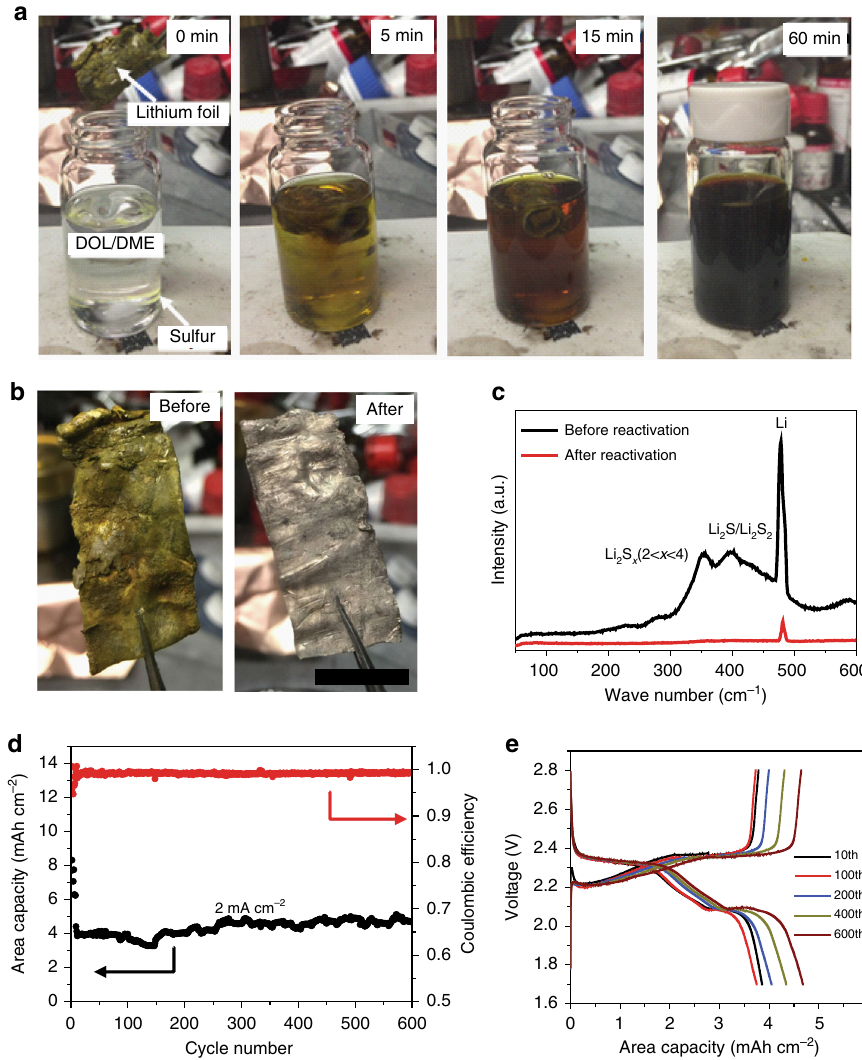
Fig. 2 Dead sul fi de species reaction with sulfur powder. a Optical images of dead sul fi de species on the surface of lithium foil after reaction with sulfur powder in DOL/DME electrolyte under stirring and heating (70 °C) condition to form polysul fi des after 0, 5, 10, and 60 min. b Optical images of lithium foil before and after dead sul fi de species reaction with sulfur powder. ( Scale bar , 2 cm) c Raman measurement of lithium foil before and after dead sul fi de species reaction with sulfur powder. d Electrochemical performance of lithium foil (after reactivation) with 5 M LPS catholyte. e Voltage pro fi les of lithium foil (after reactivation) with 5 M LPS